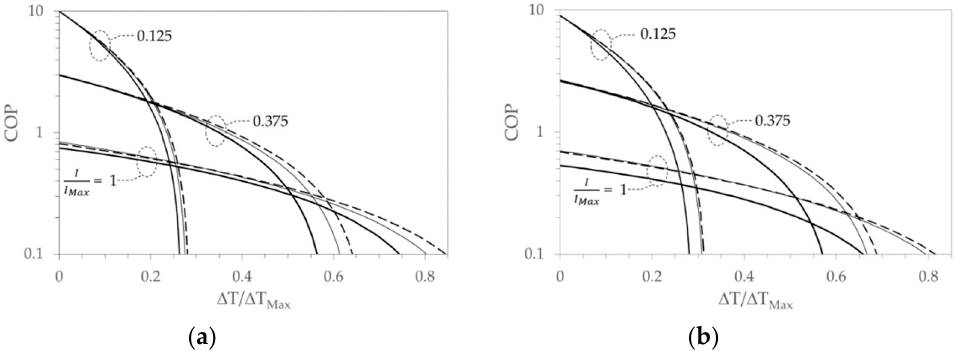
Figure 12. T H = 323.15 K . Coe ffi cient of performance against the relative temperature di ff erence Δ𝑇/Δ𝑇 (cid:3014)(cid:3028)(cid:3051) at different relative feeding current 𝐼/𝐼 (cid:3014)(cid:3002)(cid:3025) , thick solid lines represent the performed experiment, dashed lines refer to temperature-independent thermoelectric properties, thin solid lines denote the scenario in which the Seebeck coe ffi cient is temperature-dependent and both electrical resistivity and thermal conductivity are temperature independent: ( a ) case ( i ); ( b ) case ( ii ).